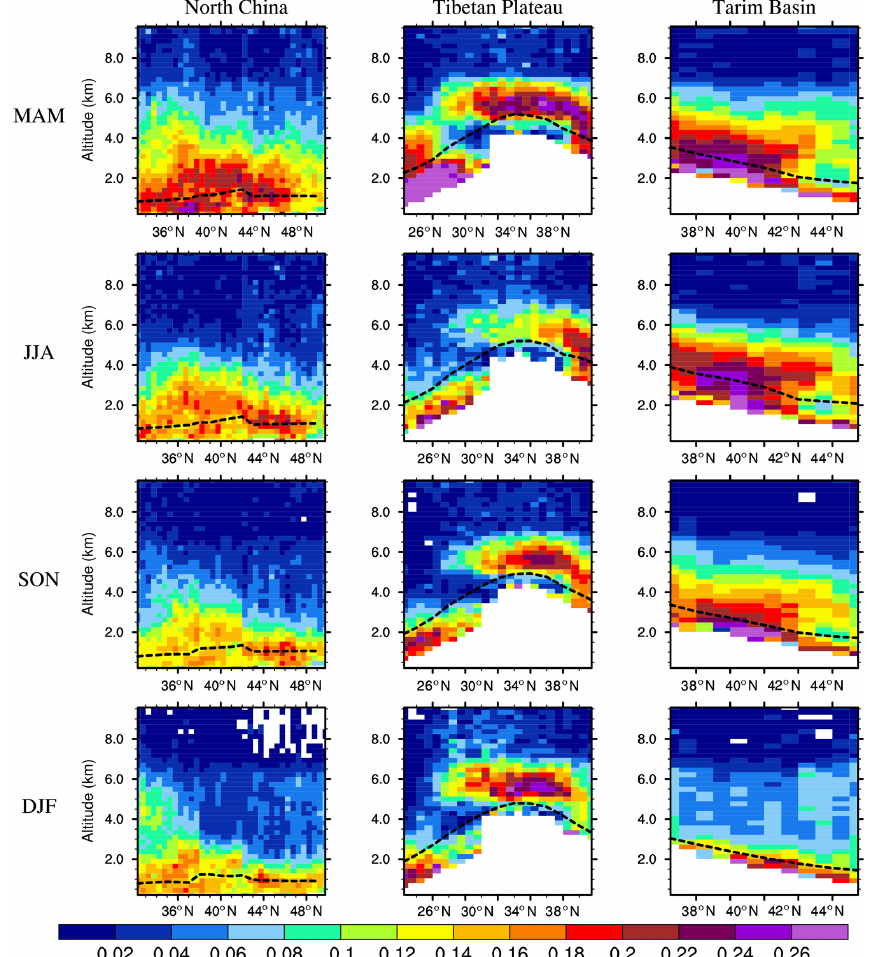
Figure 5. The vertical structure of total depolarization ratios observed from CATS by season over the three regions in relation to the zonal mean regional surface altitude. The dotted lines represent the height of the zonal mean regional planetary boundary layer (km) from the NCEP FNL reanalysis